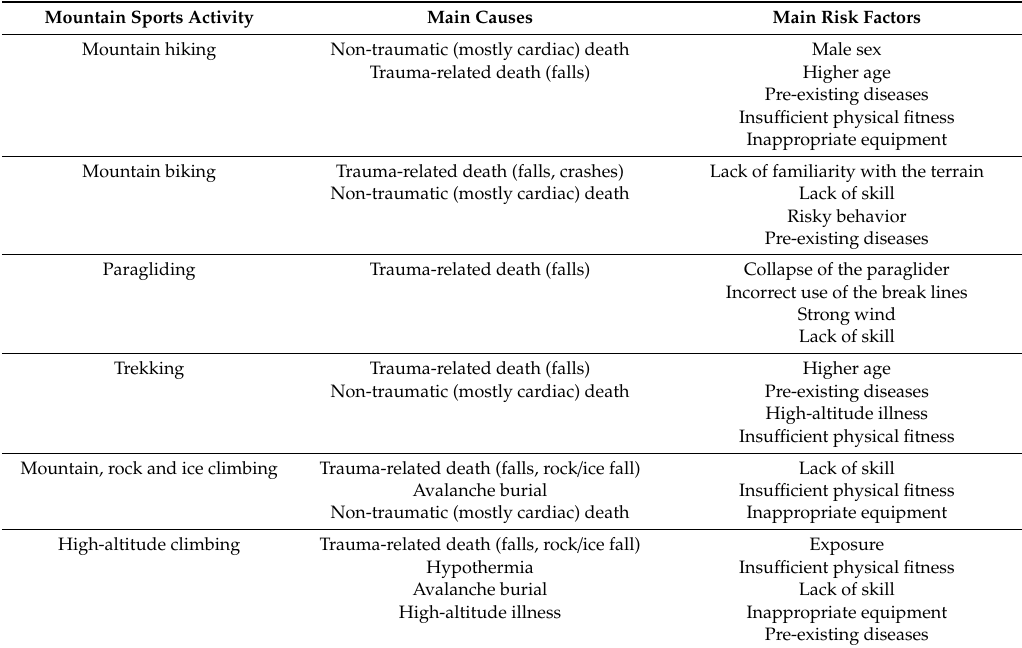
Table 2. Main causes and risk factors in di ff erent mountain sports